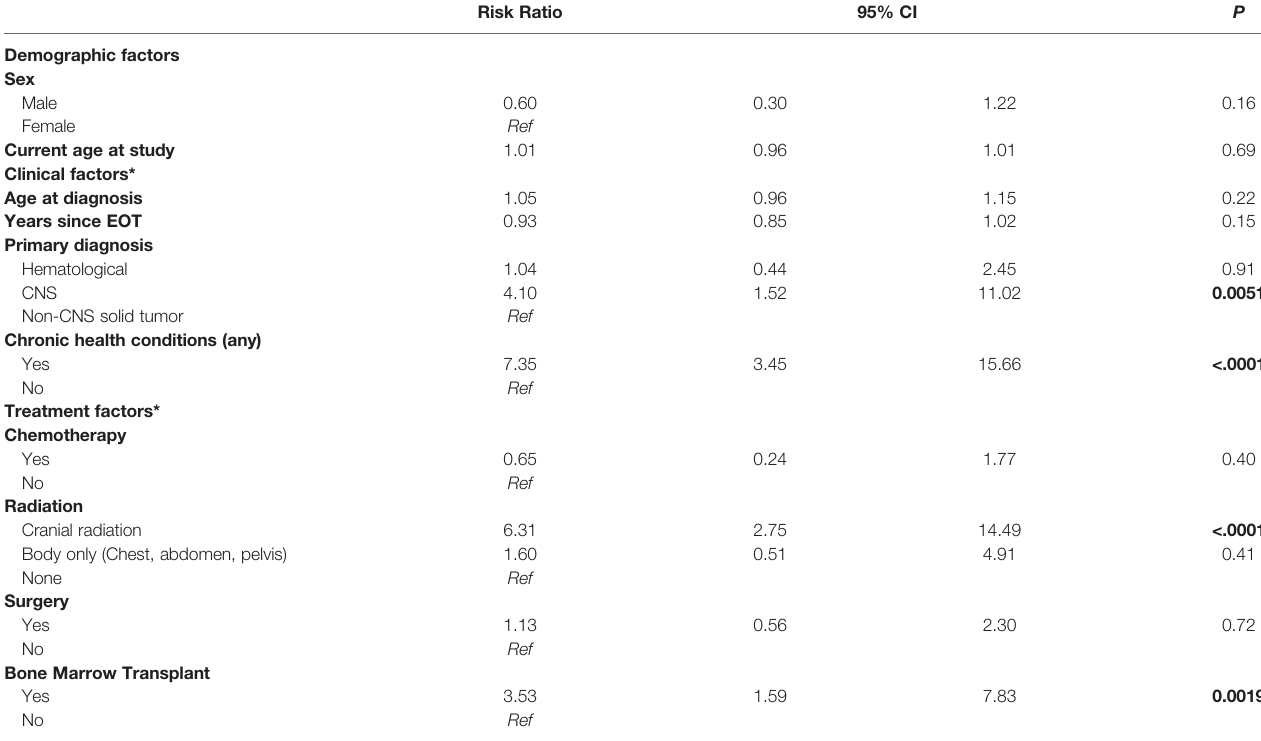
TABLE 3 | Factors associated with